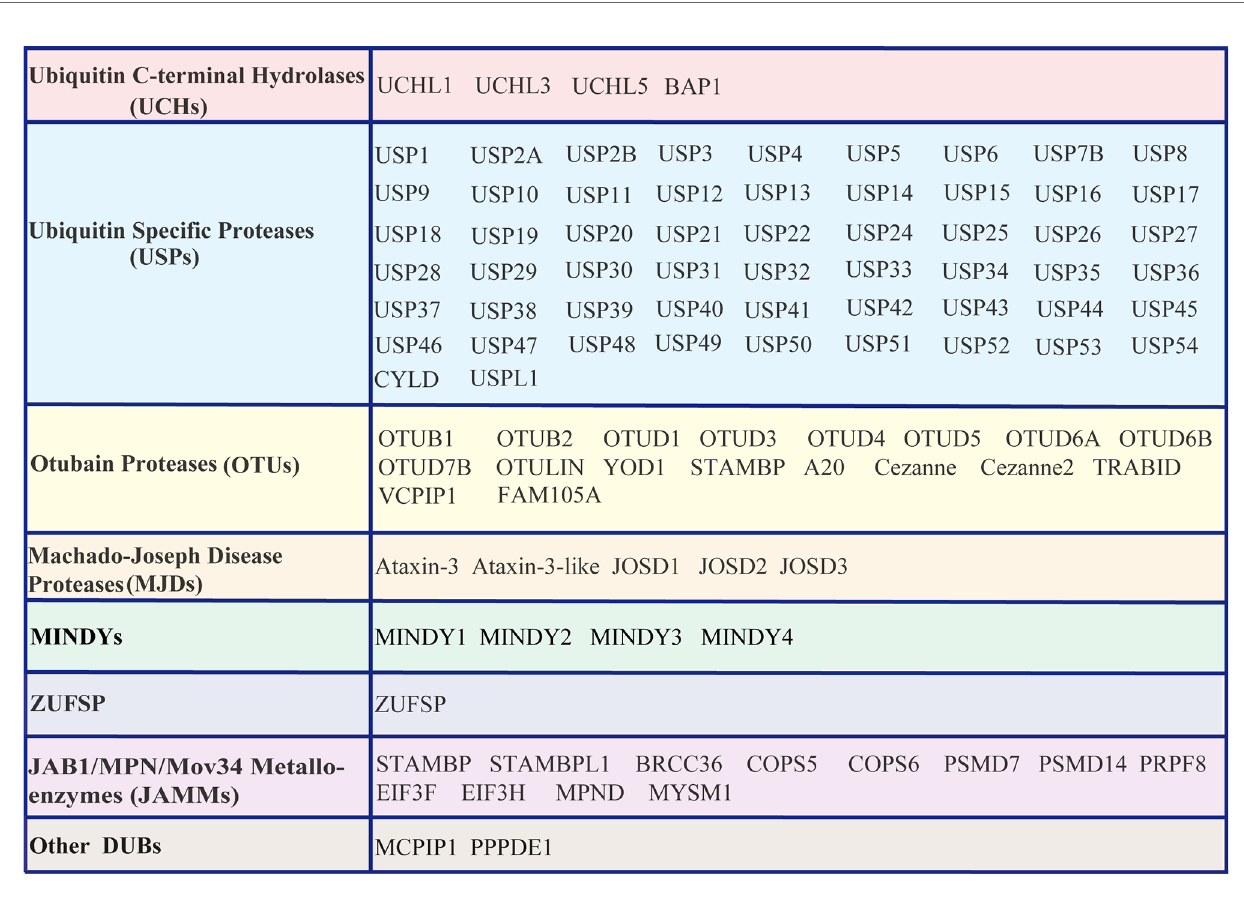
FIGURE 2 | List of DUBs identi fi ed in the human genome. These DUBs are categorized into at least seven subfamilies, namely, Ub carboxyl-terminal hydrolases (UCHs), Ub-speci fi c proteases (USPs), ovarian tumor proteases (OTUs), Machado-Joseph disease proteases (MJDs), motifs interacting with Ub (MIU)-containing novel DUB family members (MINDYs), zinc fi ngers with UFM1-speci fi c peptidase domain protein/C6orf113/ZUP1 (ZUFSP), JAB1/MPN/MOV34 metalloenzyme family members (JAMMs, also termed MPN+), and other newly identi fi ed